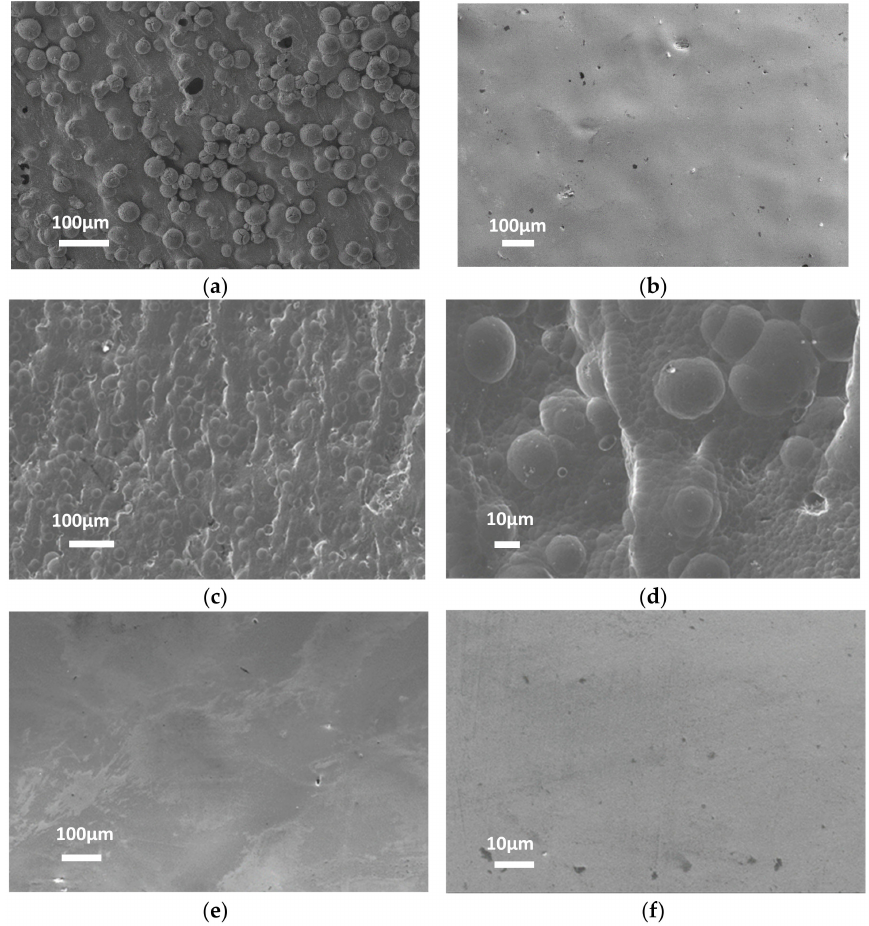
Figure 4. Surface morphology before ( a ) and after ( b ) EP of vertical samples without heat treatment; after pickling for SR, V samples at ( c ) 100 × and ( d ) 500 × magnification; after EP for SR samples at ( e ) 100 × and ( f ) 1000 ×